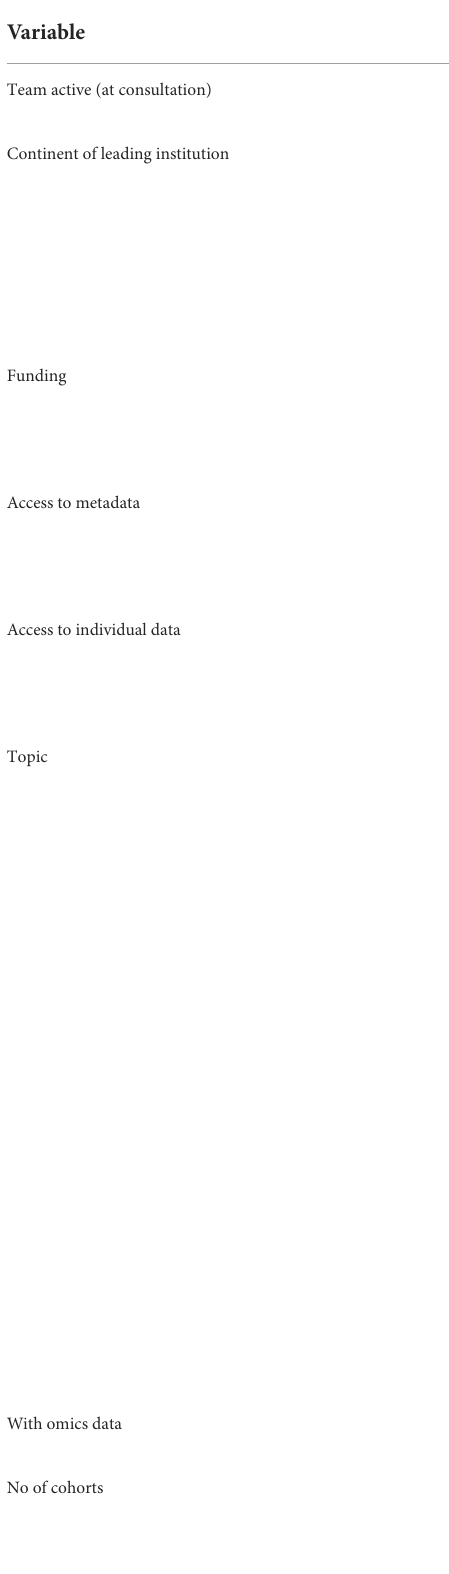
TABLE 1 Descriptive statistics of the initiatives